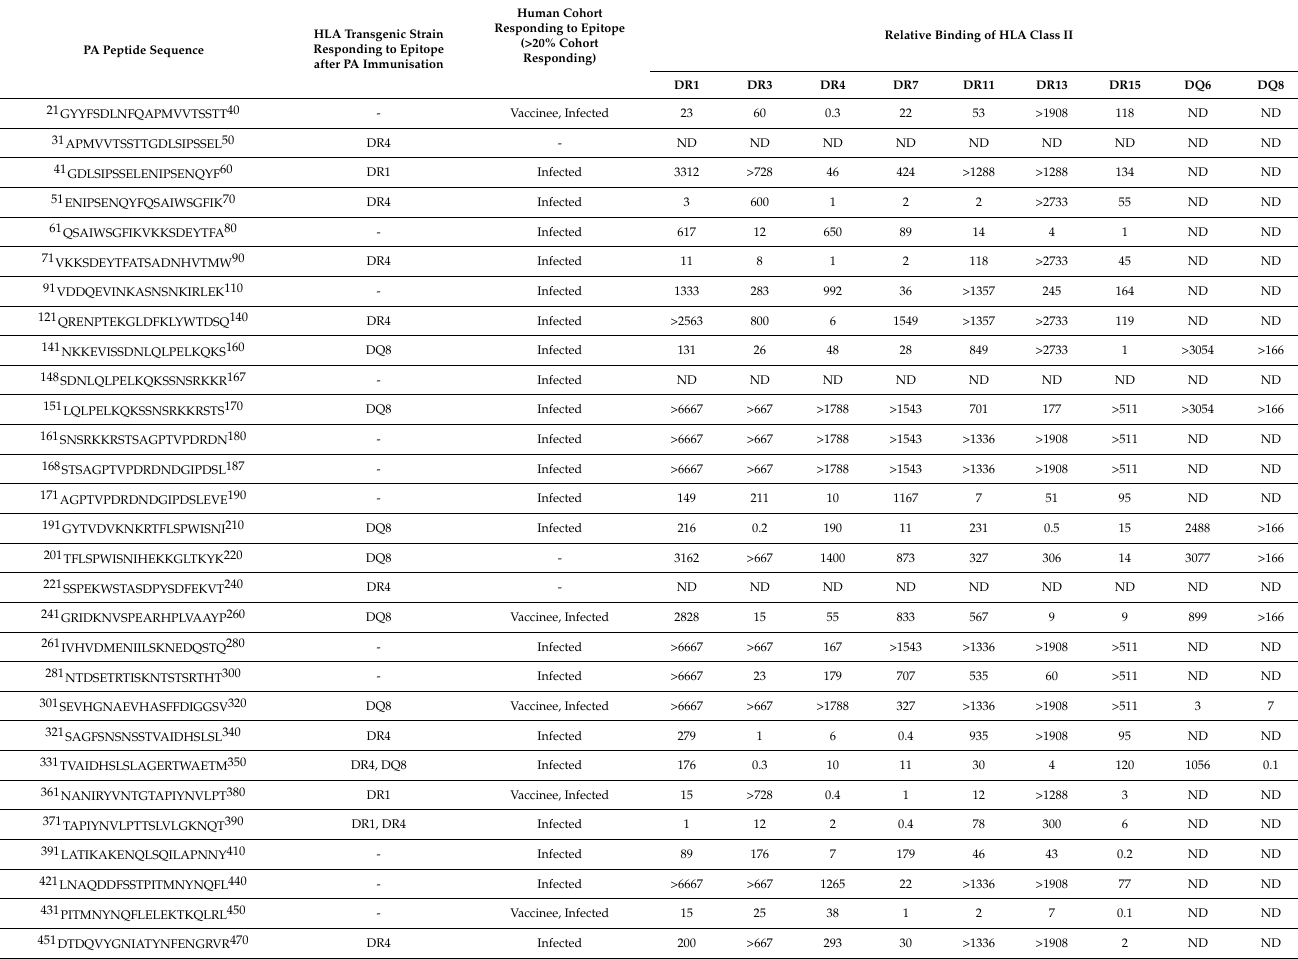
Table 1. The PA peptides, identified in transgenic mouse strains and human cohorts, show relatively broad binding to common HLA-DR and HLA-DQ